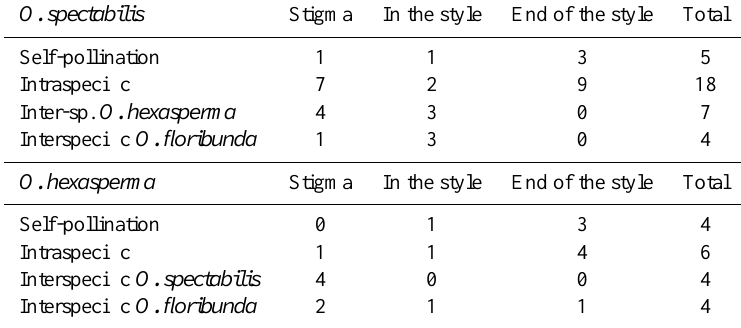
Table 3. Observed number of flowers with pollen and/or pollination tubes ending in that point of the feminine structures for each pollination